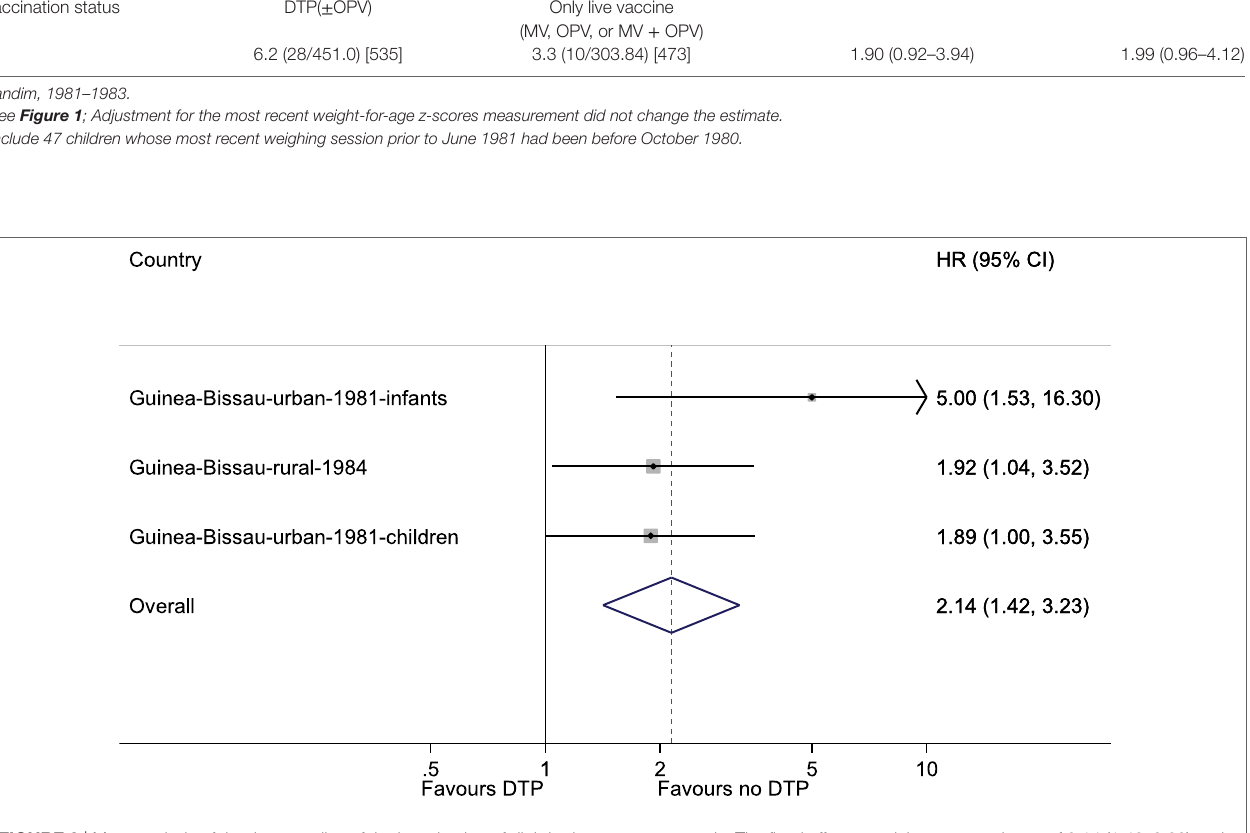
FigUre 3 | Meta-analysis of the three studies of the introduction of diphtheria–tetanus–pertussis. The fixed effects model gave an estimate of 2.14 (1.42–3.23) and the random effects model gave 2.17 (1.39–3.38).